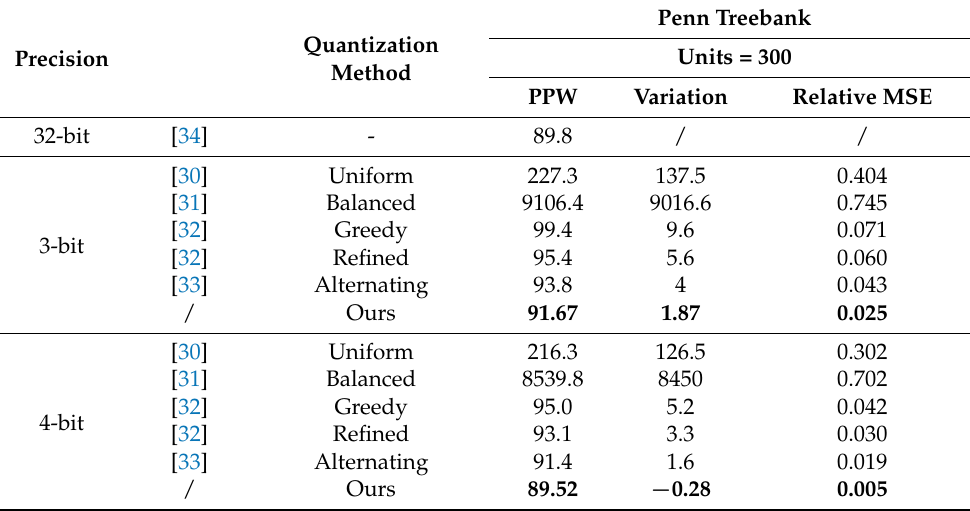
Table 5. Test PPW and Relative MSE of larger bits on Penn